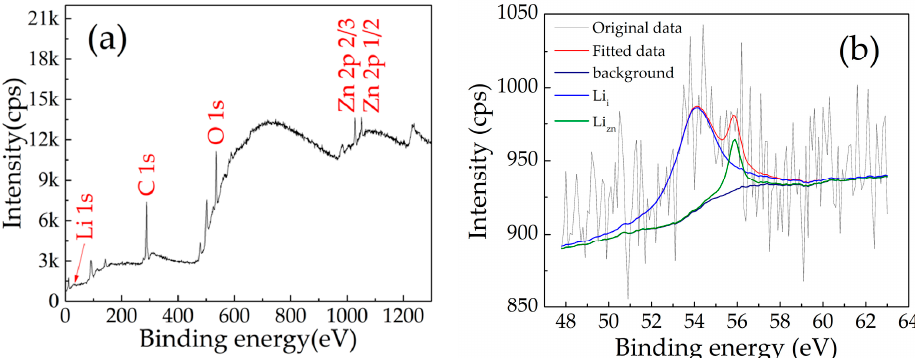
Figure 7. XPS spectra of the LZO thin film: ( a ) Full range; ( b ) narrow scan.